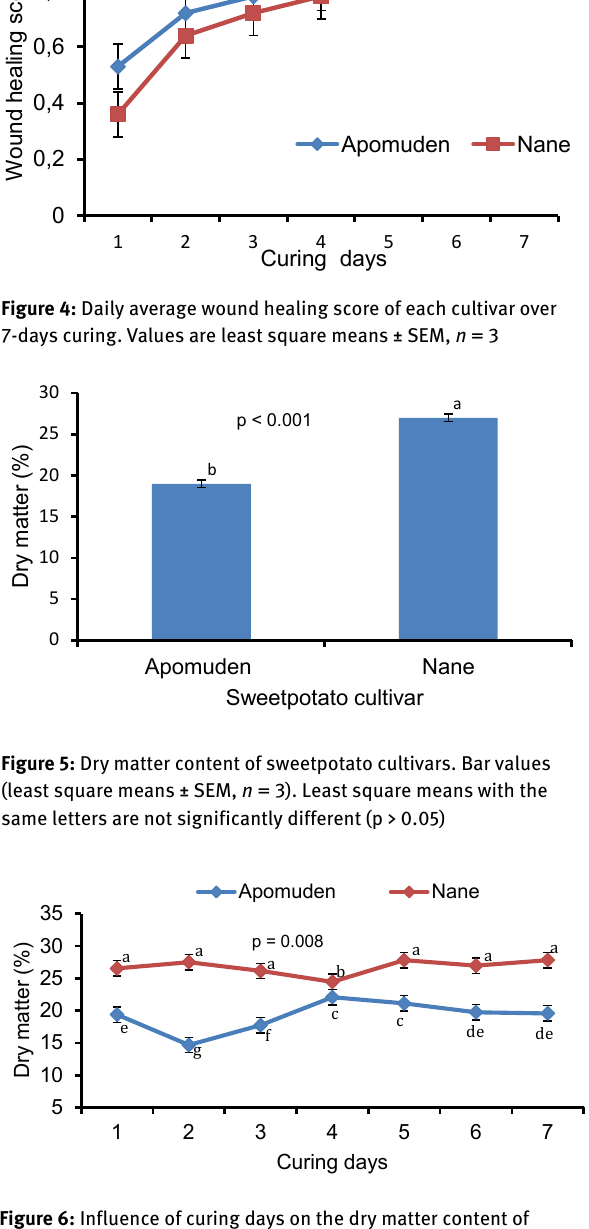
Figure 6: Influence of curing days on the dry matter content of sweetpotato over a 7-day curing period. Values are least square means ± SEM, n= 3. Least square means with the same letters are not significantly different (p > 0.05)